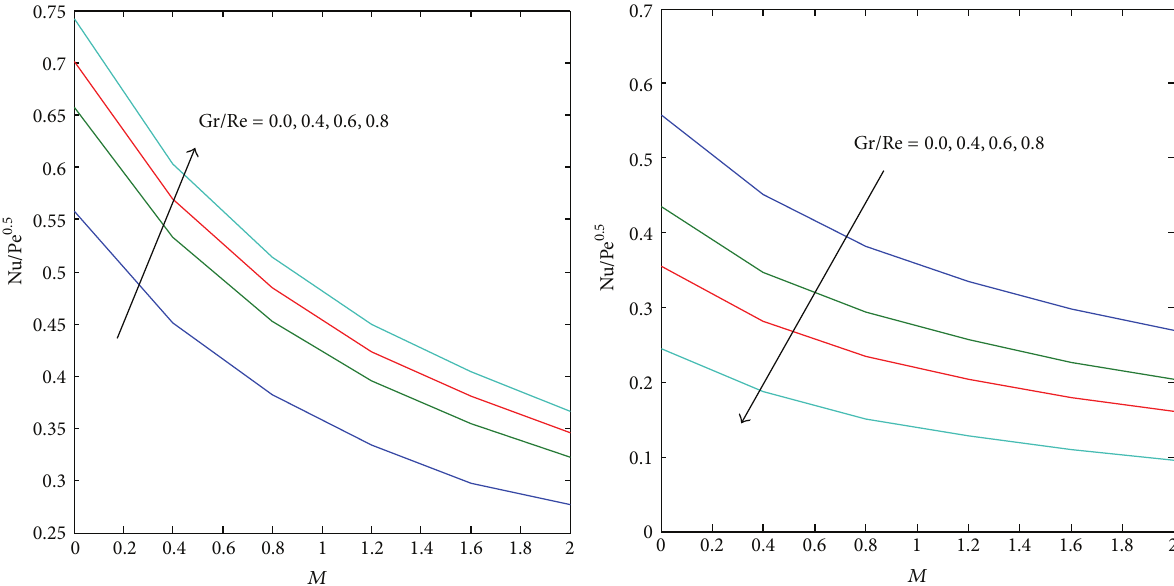
Figure 9: The Nusselt number varying with the melting parameter 𝑀 for aiding and opposing external flows and in the different mixed convection strength, 𝑁 = 0.5 , Df = 0.03 , Sr = 0.3 , and Le = 1.0